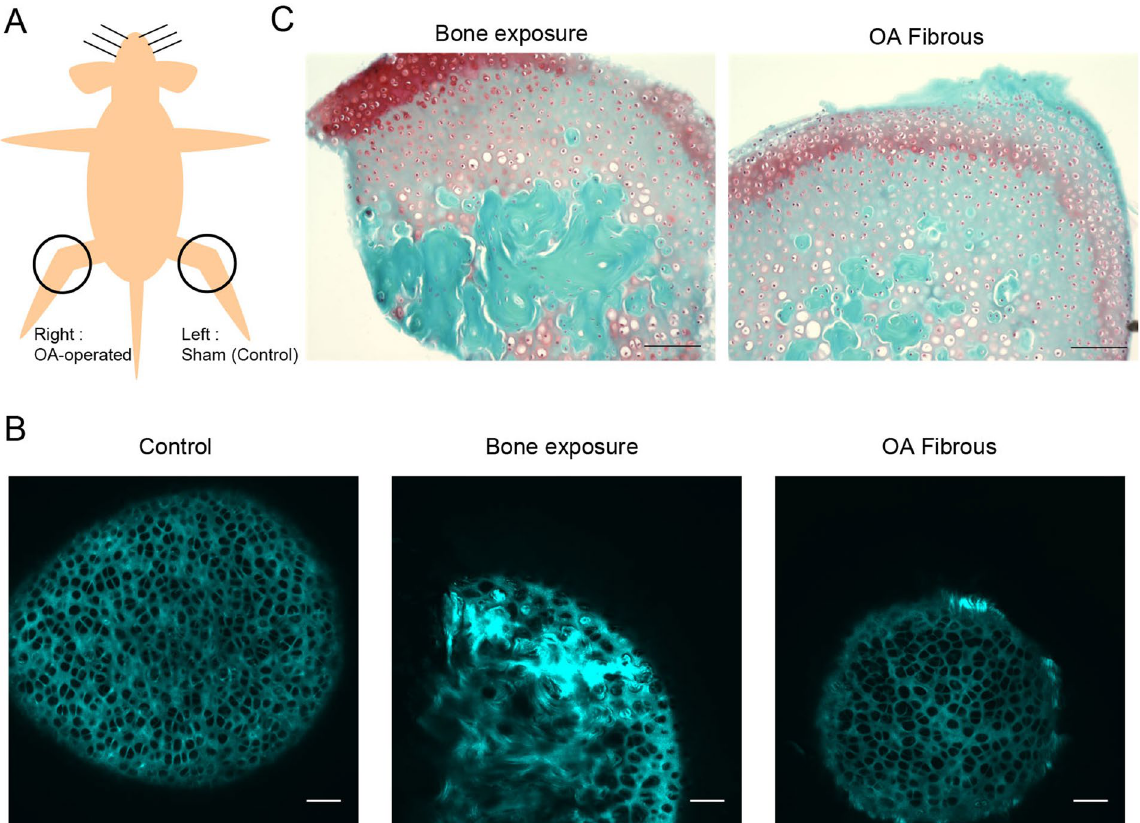
Figure 5. Applying the BoF texture analysis to the classification of SHG images of the OA model mice. ( A ) Construction of the OA mouse model. The right knee is the OA-operated side while the left knee is the sham- operated control side. Scale bar: 100 μ m. ( B ) Representative SHG images of normal cartilage from the control side (left), and degenerative cartilage from the OA side, bone exposure (middle), and hyperplasia of fibrous cartilage (right). Scale bar: 50 μ m. ( C ) Histological tissue sections from the OA-side. Typical images showing cartilage degeneration, bone exposure (left) and fibrous cartilage (right) are shown.